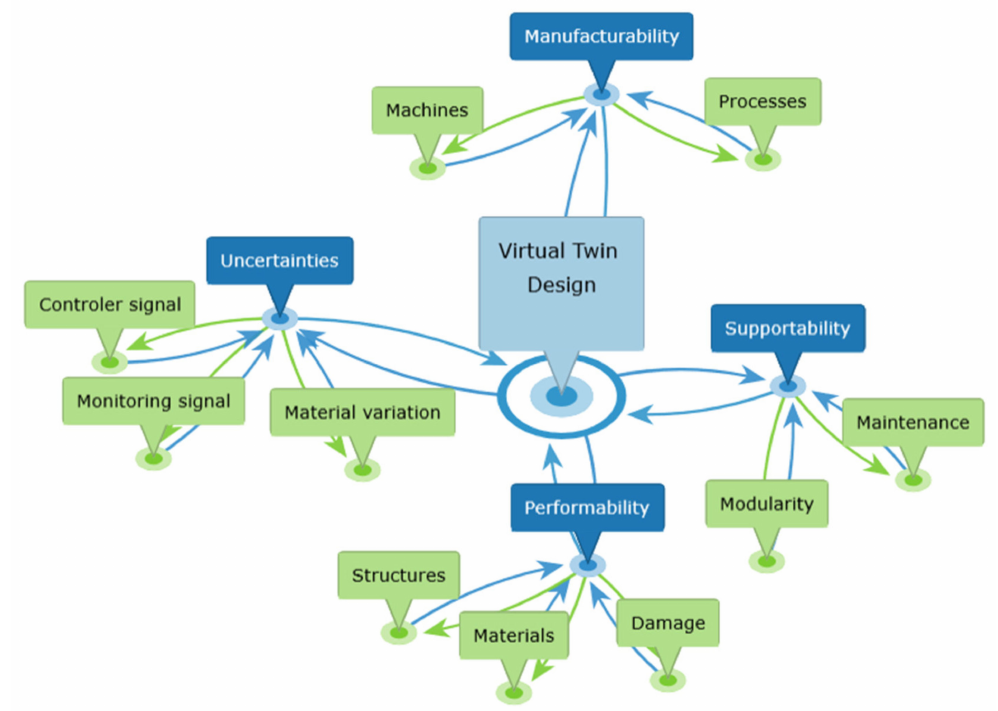
Figure 3. Digital Twin implementation model. Adopted from